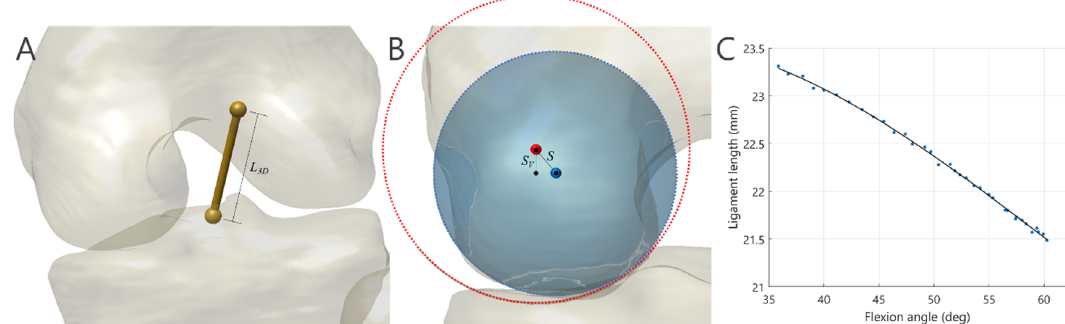
Figure 2. ( A ) The ligament length ( L 3D ) was estimated by computing the linear distance between endpoints on the femur and tibia. ( B ) The shift ( S ) and vertical shift ( S V ) of the contact sphere with respect to the centroid axis of the curved surface of the tibial plateau were taken to account for the violation of ideal joint congruency. The blue and red circles represent cross sections of the contact sphere and the tube model, respectively. ( C ) A 3rd-order polynomial function fitting to the discrete ligament lengths obtained from the registered tibiofemoral kinematics was intended to provide subject- and task-specific representation of ligament elongation along with the knee flexion angles.